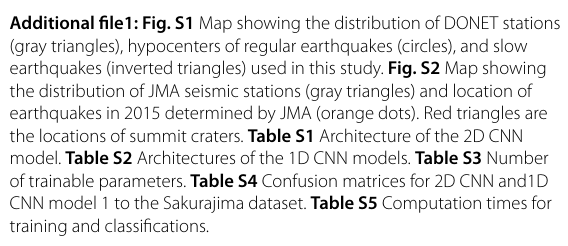
model. Table S2 Architectures of the 1D CNN models. Table S3 Number of trainable parameters. Table S4 Confusion matrices for 2D CNN and1D CNN model 1 to the Sakurajima dataset. Table S5 Computation times for training and